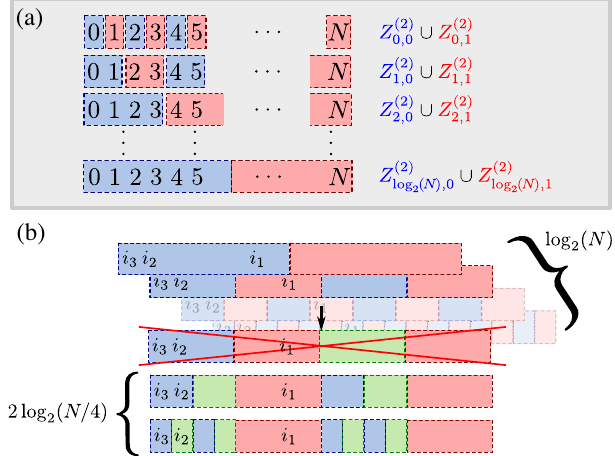
FIG. 2. Schematics of the binary partition strategy described in the main text. (a) Scheme to construct O ð log N Þ cliques that contain all two-qubit operators. (b) Extension of the top scheme to a set of O ð log 2 N Þ cliques that contain all three-qubit